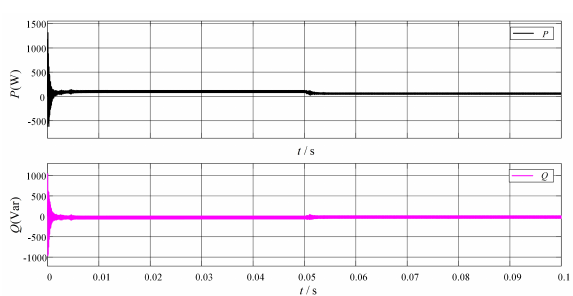
Fig. 15. Active and reactive power of inverter